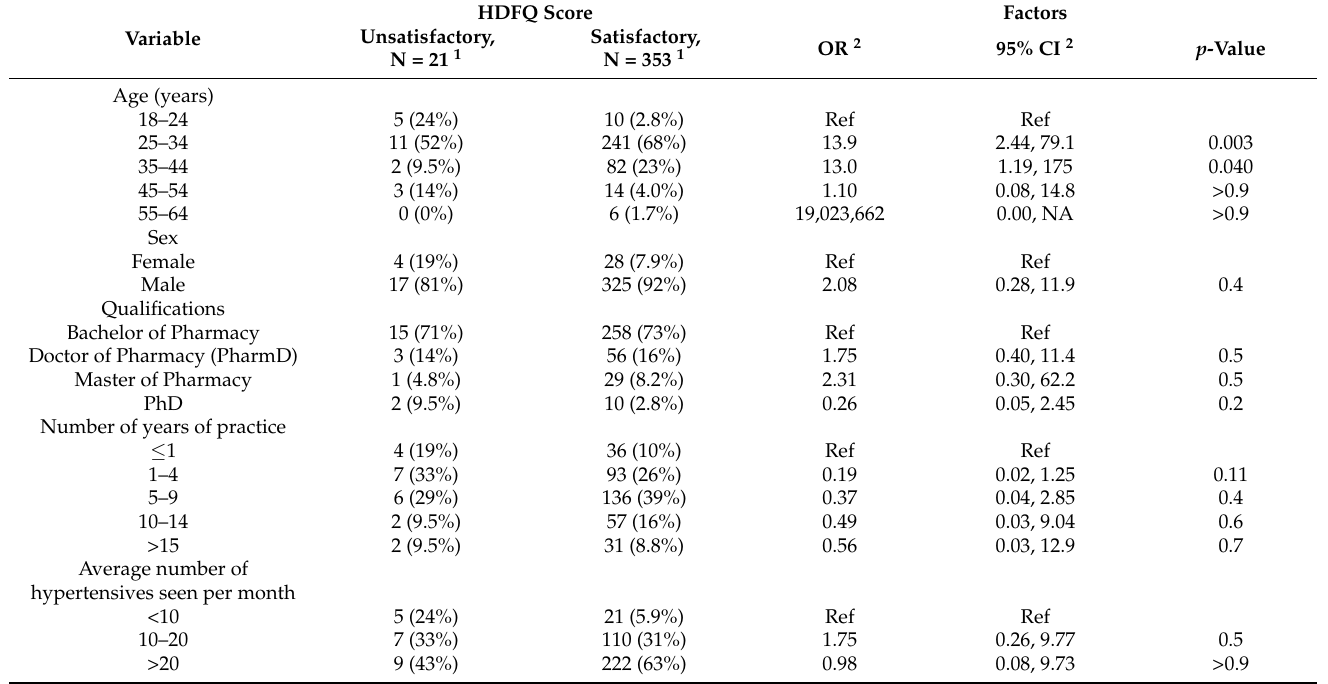
Table 4. Association between HDFQ score category and socio-demographic cists aged 25 to 34 and 35 to 44 years old were nearly 14-fold (AOR = 13.9, 95 % CI: 1.19–